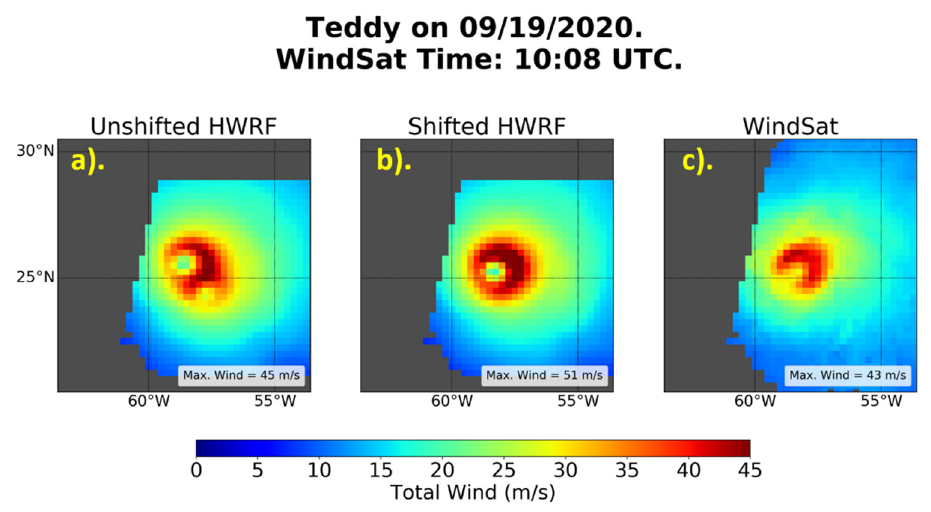
Figure 10. Three wind fields for the WindSat pass over Hurricane Teddy on 19 September 2020 at 10:08 UTC. ( a ) The resampled HWRF wind field that has been temporally interpolated to the time of the WindSat overpass, ( b ) the resampled HWRF winds that have been shifted to the WindSat storm center and then temporally interpolated to the time of the WindSat overpass; i.e., the shifting methodology described in the text, and ( c ) the wind field from the WindSat pass itself.